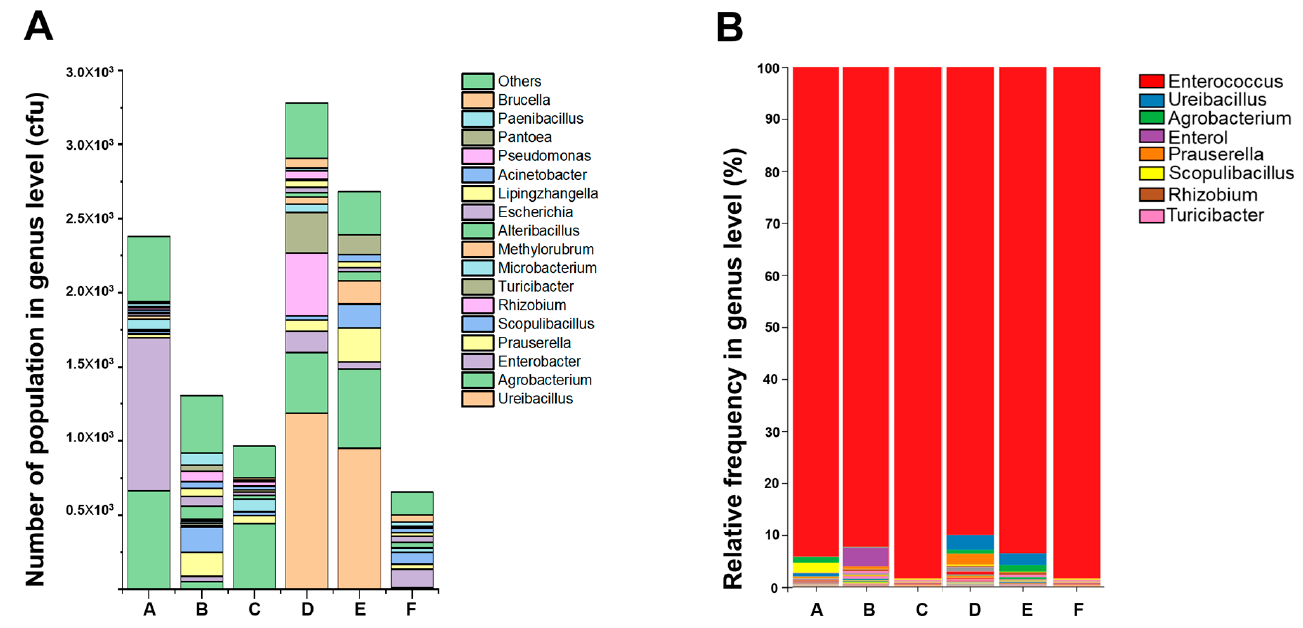
Figure 1. Comparison of the gut microbiota of Spodoptera frugiperda larvae fed on each of the six corn